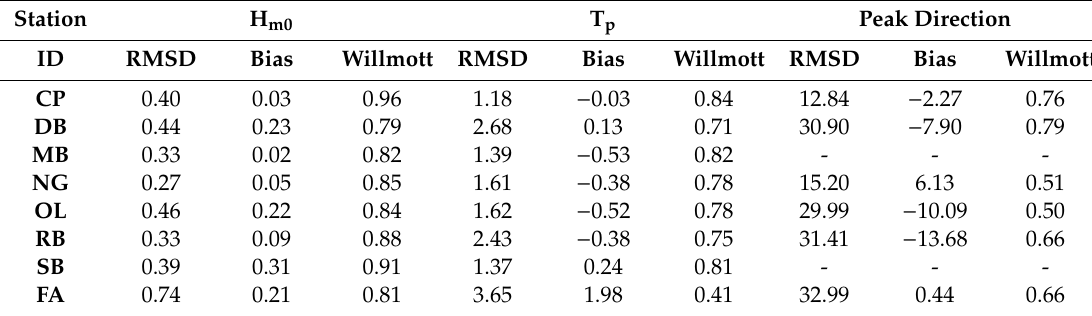
Table A5. Model performance statistics per coastal buoy location for JJA 2017, M5.